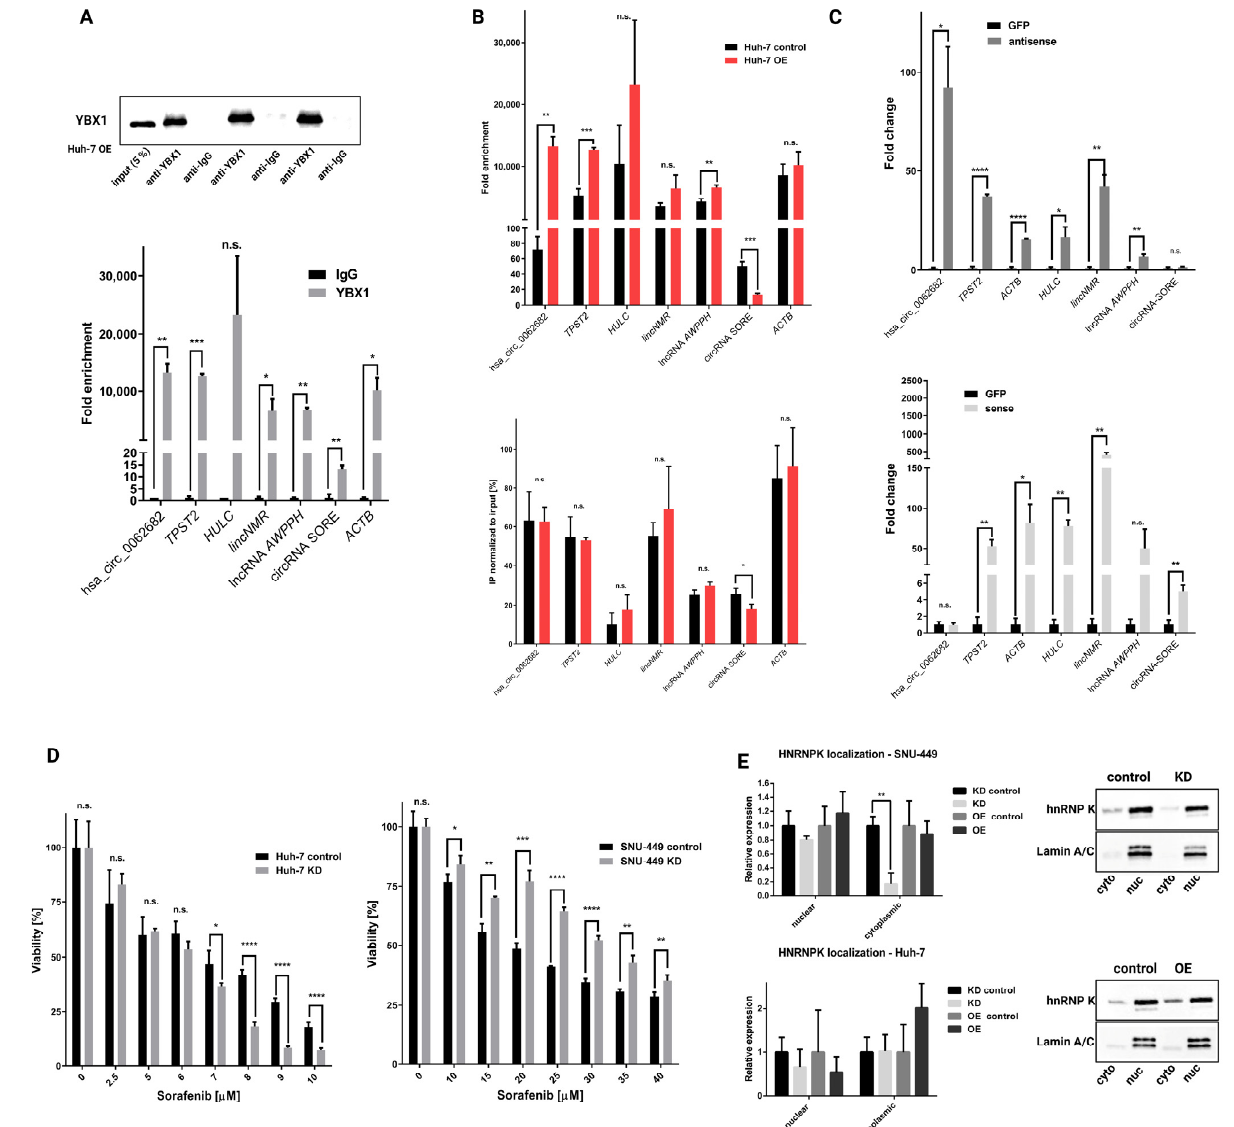
Figure 7. Hsa_circ_0062682 binds to YBX1 and its effect is cell-context dependent. ( A ) Confirmation of a specific pulldown from RNA immunoprecipitation of YBX1 by Western blotting (up); enrichment of RNA species from RNA immunoprecipitation by RT-qPCR (n = 3) (down); ( B ) comparison of RNA immunoprecipitation enrichment between Huh-7 OE and Huh-7 control cell line normalized to expression levels in IgG fractions (top) or expression levels in the input (bottom) (n = 3); ( C ) enrichment of RNA species in biotinylated oligonucleotide pulldowns normalized to biotinylated anti-GFP oligonucleotide pulldown; antisense (up), sense (down) (n = 3); ( D ) viability of sorafenib treated KD cell lines measured by colourimetric CCK-8 assay (n = 4); ( E ) hnRNP K localization in hsa_circ_0062682 stable cell lines identified by Western blotting (n = 3); OE: overexpression; KD: knockdown; cyto: cytoplasmic fraction; nuc: nuclear fraction. Results are represented as averages and error bars represent standard deviation. * p -value ≤ 0.05; ** p -value ≤ 0.01; *** p -value ≤ 0.001; **** p -value ≤ 0.0001; n.s.: not